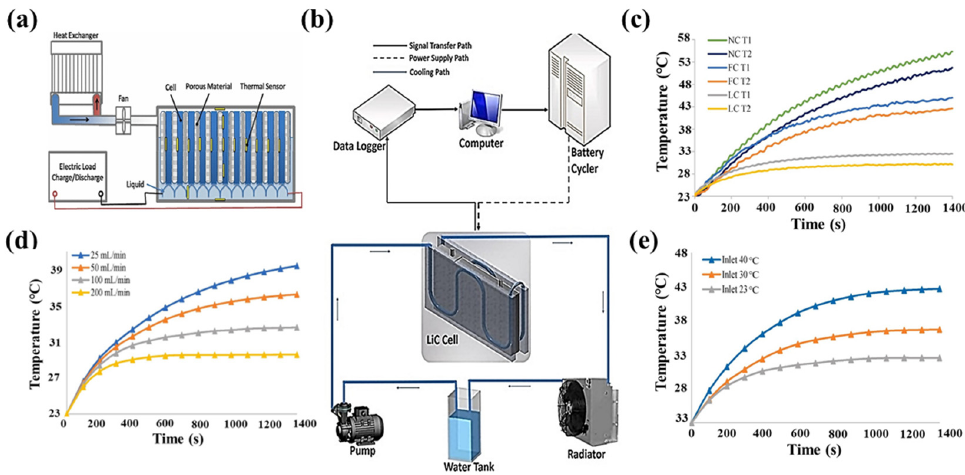
Figure 18. ( a ) Direct contact liquid cooling system, reproduced with permission from [162], copyright 2014, IEEE, ( b ) indirect contact liquid cooling system, ( c ) graphs of temperature versus time under the following three laboratory tests: natural air convection (NC), forced air convection (FC), and liquid cooling (LC) for LICs, ( d ) temperature trends over time at various flow rates, and ( e ) temperature variation trends over time for a variety of inlet cooling medium temperatures, reproduced with permission from [165]. Copyright 2020,